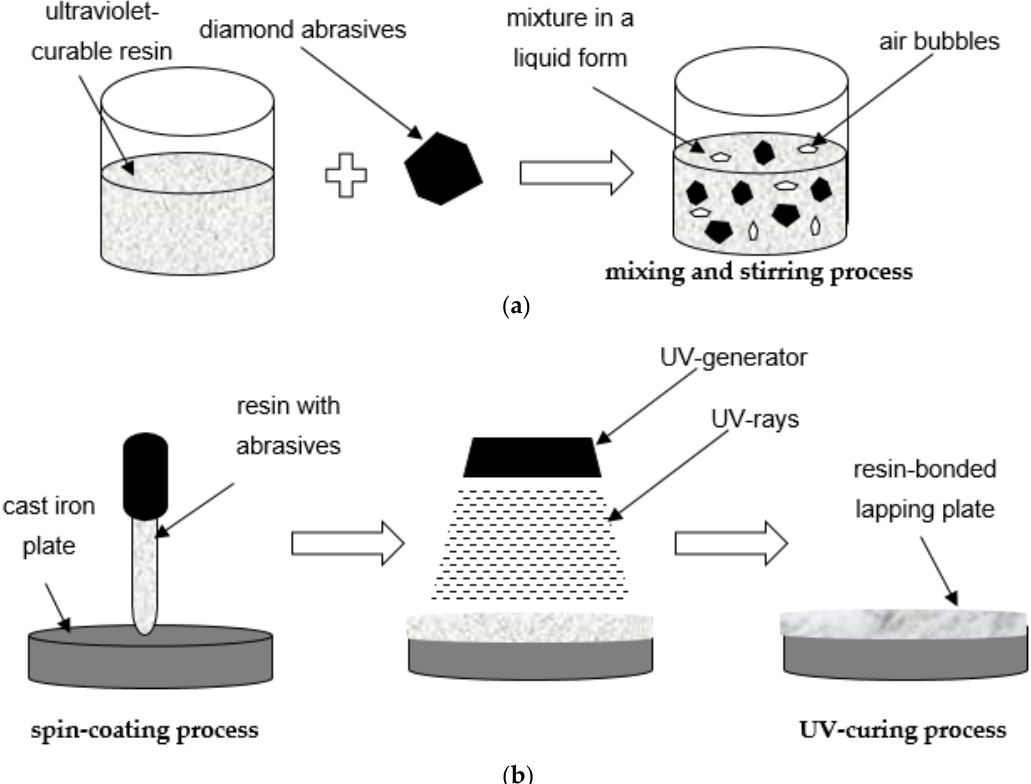
Figure 7. The fabrication process of a resin-bonded lapping plate: ( a ) preparation of mixed ultraviolet-curable resin and diamond abrasives; ( b ) UV-curing process with the use of spin-coating method; based on references [95,97].